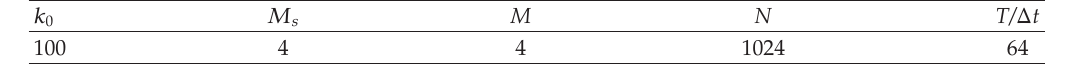
Table 1: Common parameters for both kinds of numerical experiments.